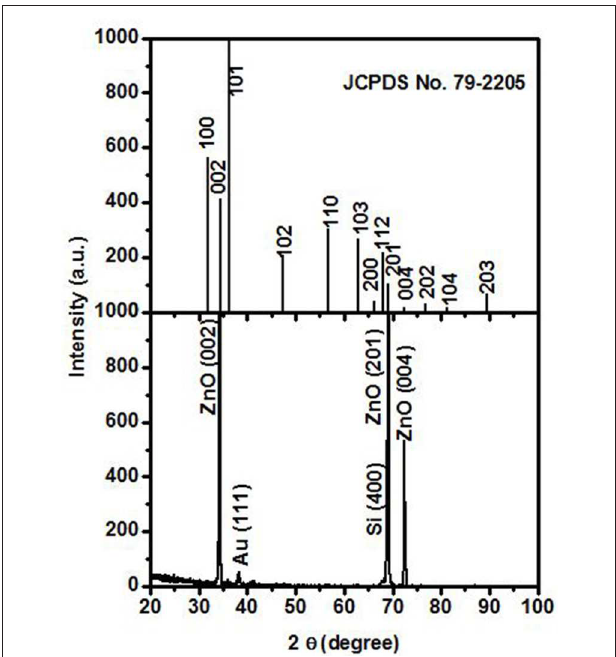
FIGURE 1 | XRD of ZnO nanorods sample. The up panel and the low panel are from JCPDS No. 79-2205 and ZnO nanorods sample,